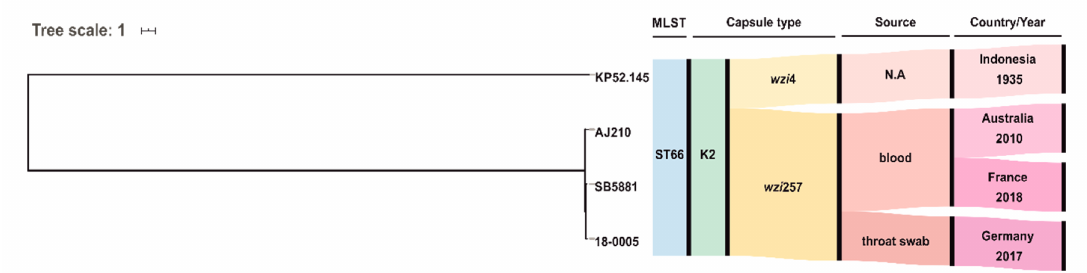
Figure 2. Phylogeny of the four hvKp strains Kp.52.145, AJ210, SB5881 and 18-0005 (this study). The maximum likelihood tree was calculated by PhyML based on single nucleotide polymorphisms (SNPs) filtered after mapping to the Kp52.145 sequence. N.A. not available